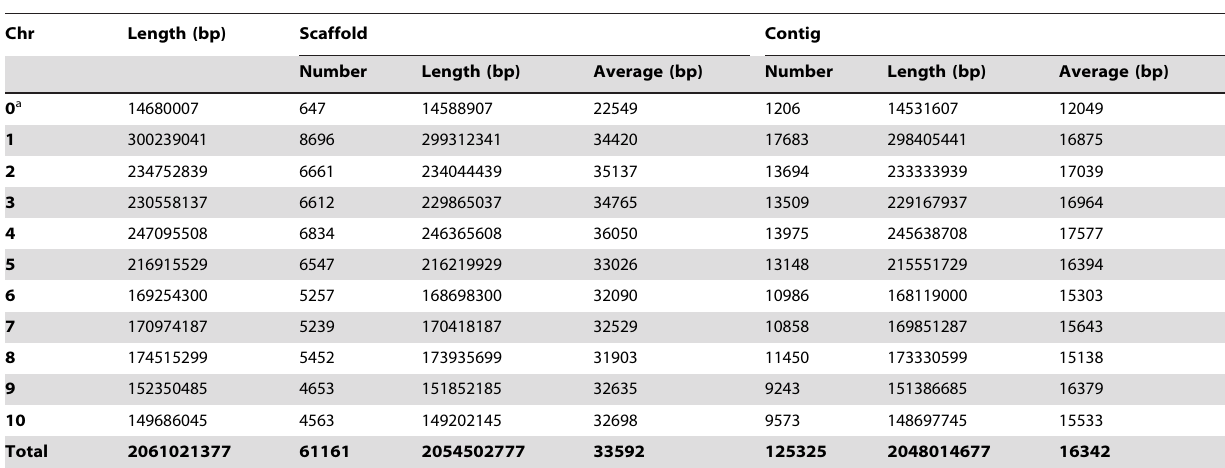
Table 3. Sequence summary of the maize chromosomes in B73